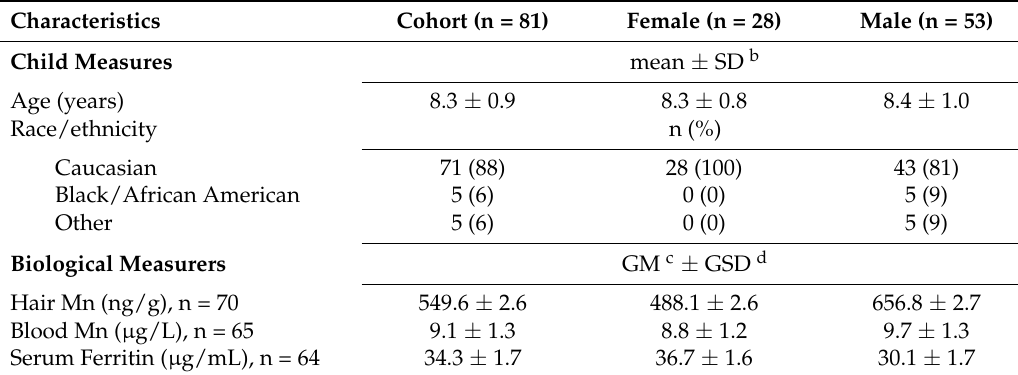
Table 1. Demographic characteristics and biological measurers of children enrolled in CARES a from Guernsey County, OH, USA.